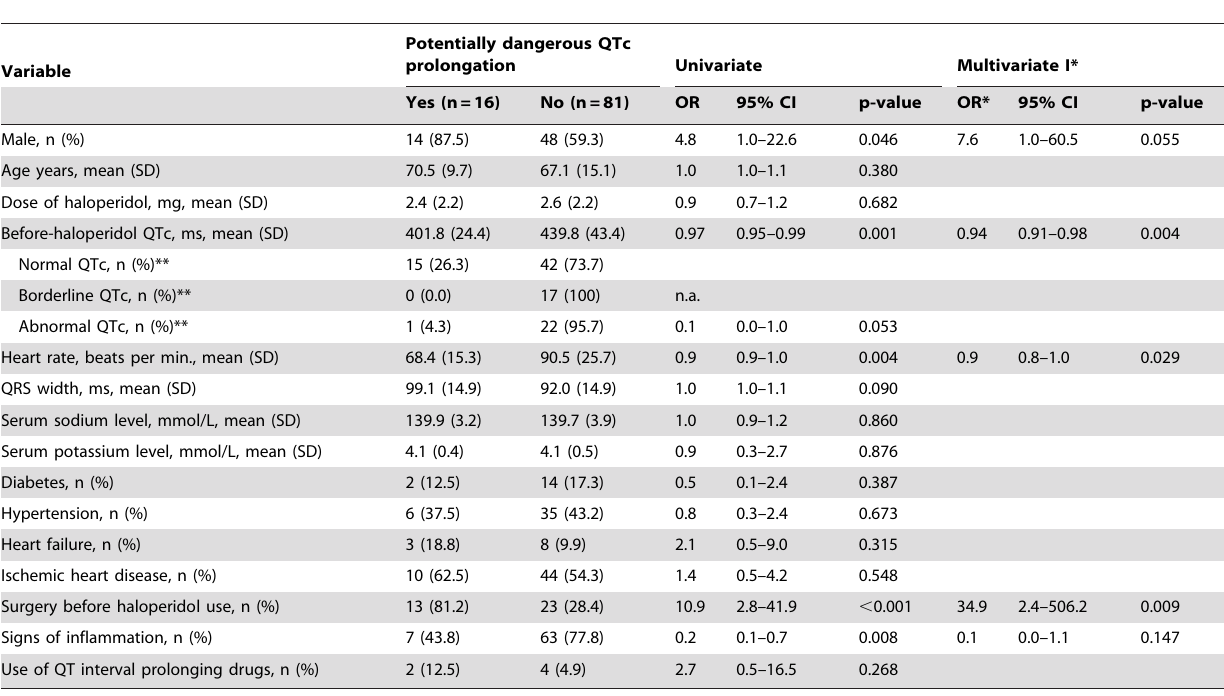
Table 2. Unadjusted and adjusted Odds Ratios for potentially dangerous QTc prolongation.